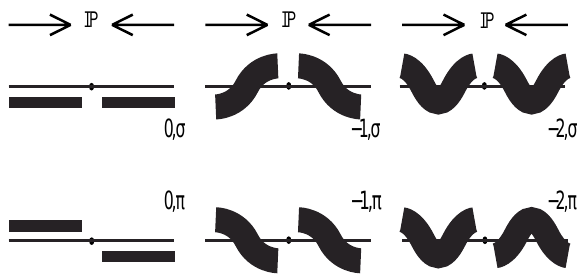
FIG. 4. Schematic view of the coherent synchrobetatron beam- beam modes.